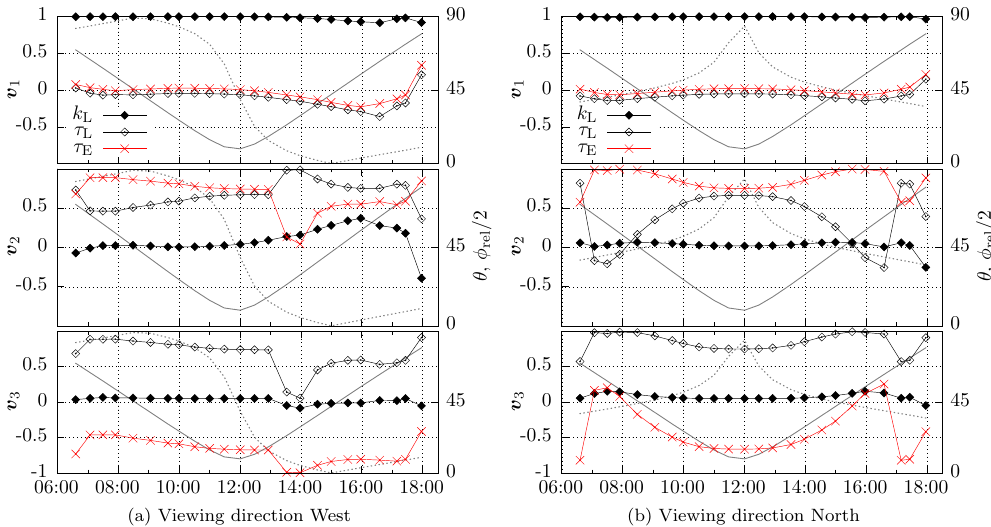
Fig. 4. Singular vectors related to the singular values in Fig. 3 for the ground layer profile with τ ∼ 1.2 (Fig. 2, bottom row), again for viewing directions west (a) and north (b)